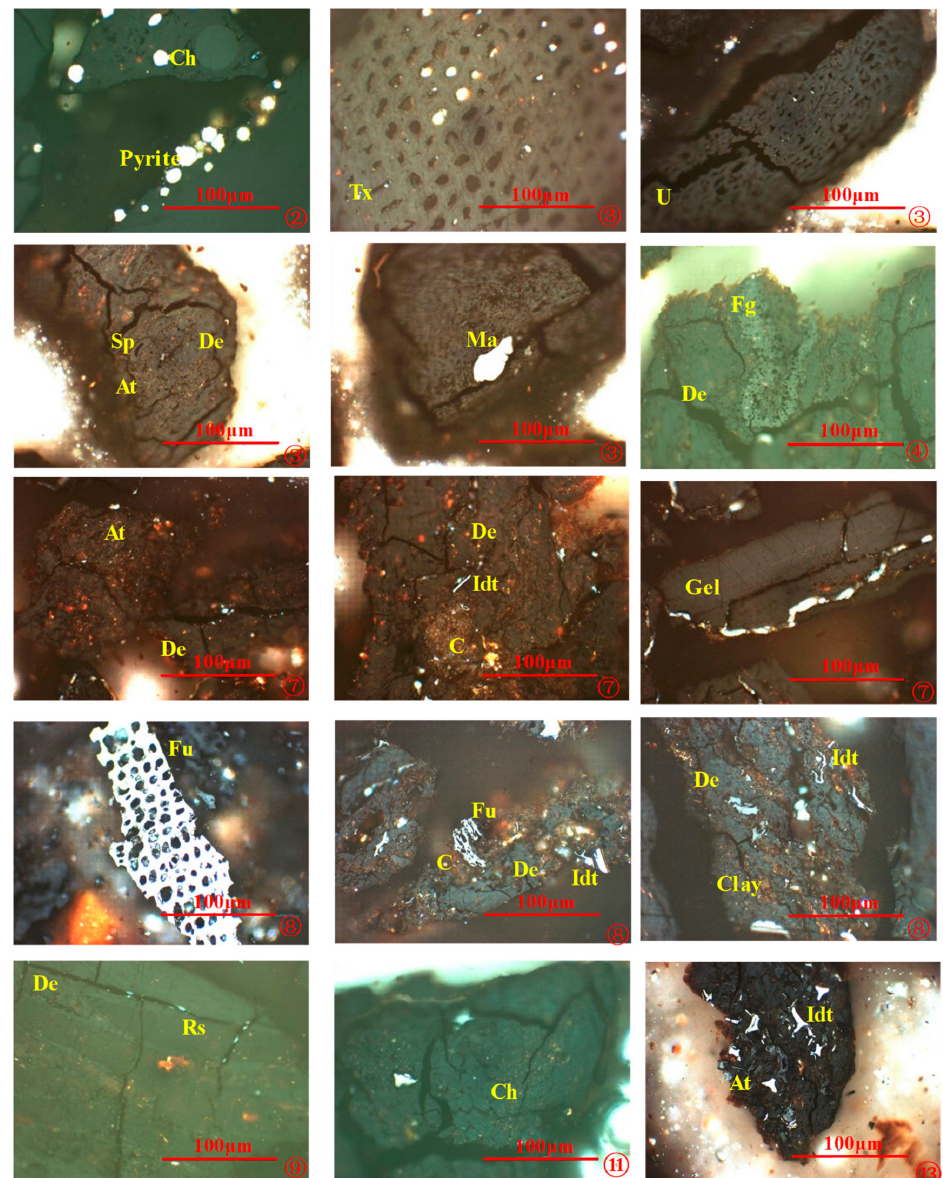
Figure 4. Macerals photos (the sample number is given at the lower right corner in each photo as red circled digit); Tx, Textinite; U, Ulminite; At, Attrinite; De, Densinite; Gh, Gelohuminite; Ch, Corpohuminite; Fu, Fusinite; Ma, Macrinite; Idt, Inertodetrinite; Sp, Sporinite; Cu, Cutinite; Rs,